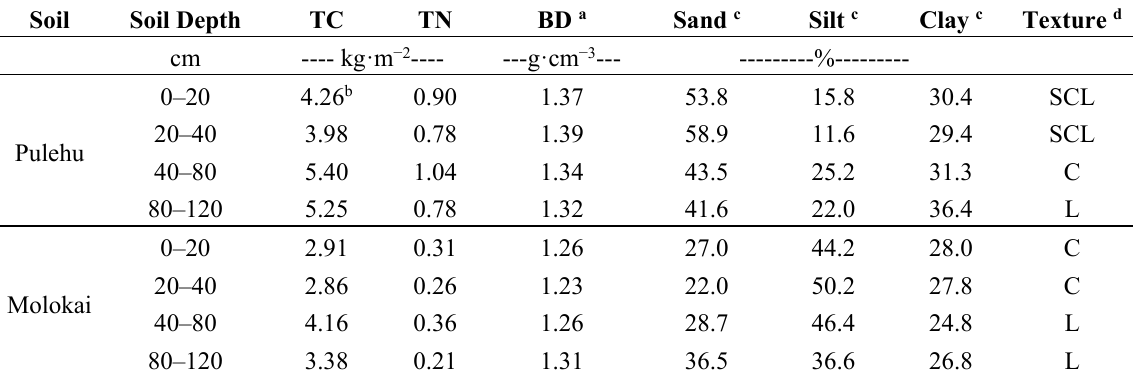
Table 2. Soil Total Carbon and Nitrogen and Physical Properties of the Experimental Fields. Soil Soil